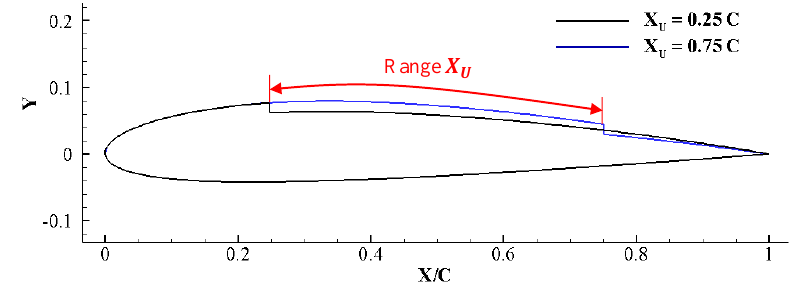
Figure 5. The two extreme locations of the step on the upper surface of the NACA 2412.